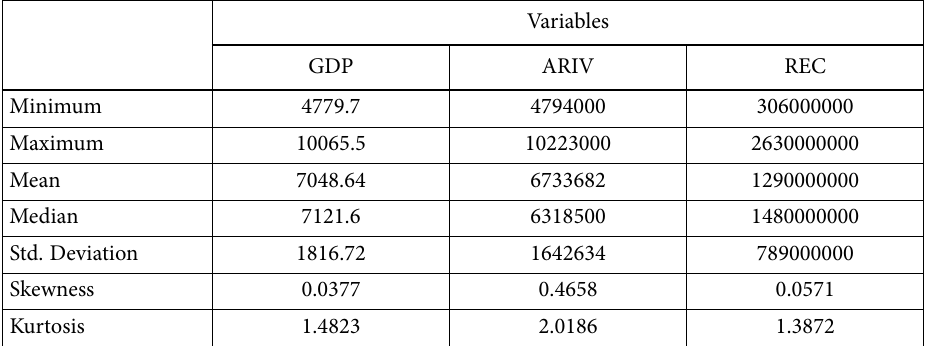
Table 2. Descriptive statistics (source: World Development Indicators (The World Bank,